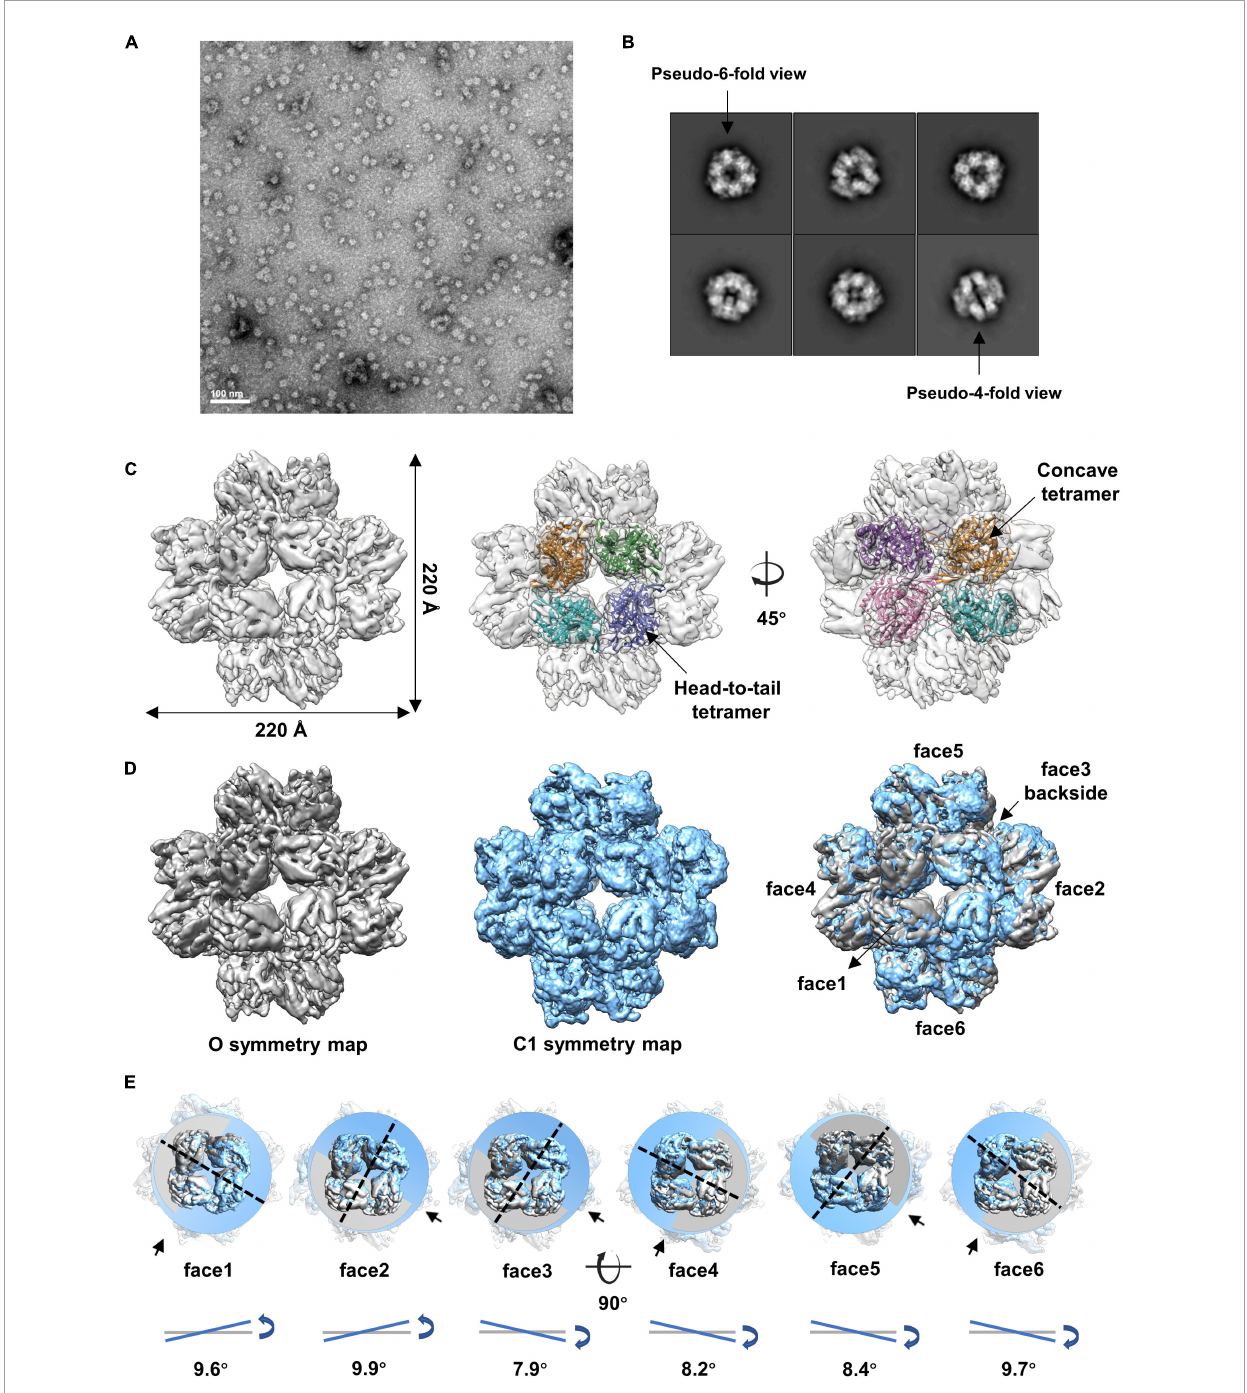
FIGURE2 Cryo-EM reconstructions of the small cube-like gp105 particles calculated with O and C1 symmetry, respectively. (A) A representative negative-staining micrograph showing the particles of gp105 from the peak2 of SEC. (B) 2D class averages of the gp105 cube-like assembly. (C) Surface rendered representations showing the cryo-EM map of the gp105 cube-like assembly reconstructed with O symmetry imposed (O map). The fitted gp105 (residues 61–577) structures show the head-to-tail (middle) and concave tetramers (right). The gp105 structure was predicted by using AlphaFold and each gp105 monomer is colored differently. The map is contoured at 2.3 σ . ( D , Left) Surface rendered representations showing the cryo-EM map of the gp105 cube-like assembly reconstructed with O symmetry imposed (O map). (Middle) Surface rendered representation showing the cryo-EM map of the gp105 cube-like assembly reconstructed without applying any symmetry (C1 map). (Right) Superimposition of the C1 and O maps. The maps were superimposed by maximizing the map correlation coefficient of the aligned maps with the Fit in Map function of Chimera. Different faces of the octahedron are marked by different numbers. The C1 map is contoured at 2.3 σ and the O map is contoured at 2.4 σ . (E) Analysis of the superimposed maps at each face showing the positional deviation of the head-to-tail tetramers in the C1 map relative to these in the O map. The planes were generated with the fitted models of the head-to-tail tetramers and the Structure Measurements function of Chimera. The tilt angles are calculated with the